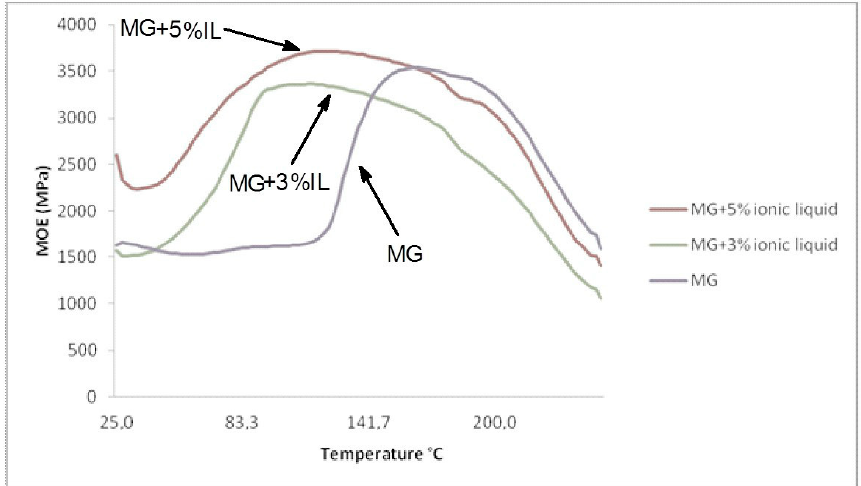
Figure 2. Comparative thermomechanical analysis curves of the rate of hardening of MG resins with and without addition of IL.